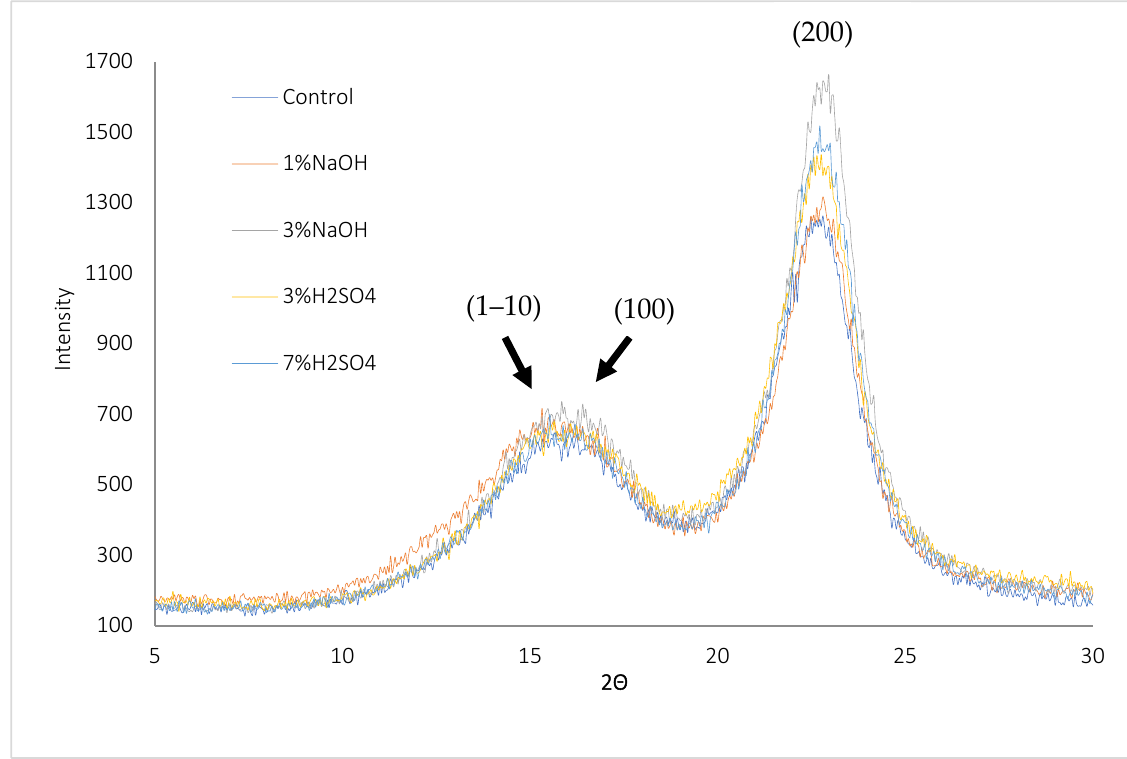
Figure 5. X-ray diffraction pattern of poplar cellulose before and after pretreatment.